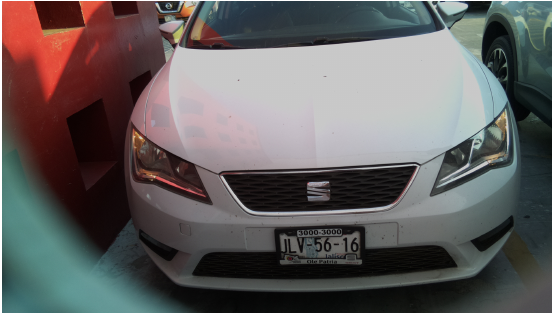
Figure 18. Image captured with the